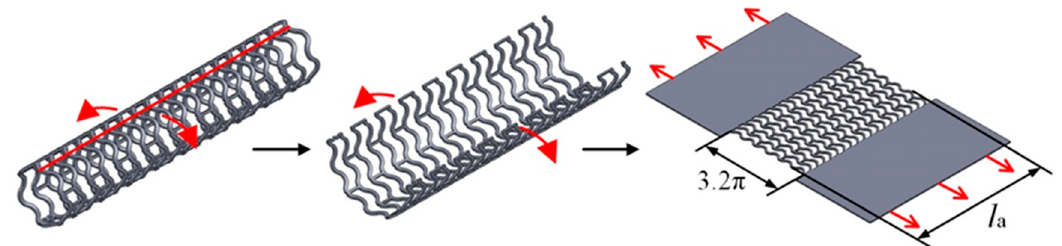
Figure 3. Planar specimen with a chosen stent design pattern for the stretching tests.